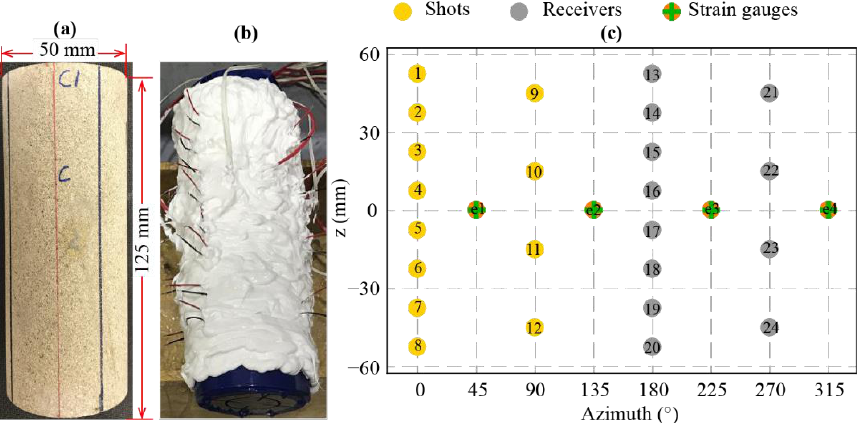
Figure 1. ( a ) Rock sample; ( b ) the sample coated with silicone sealant; ( c ) cylindrical expansion view of the installation position of transducers and strain gauges.